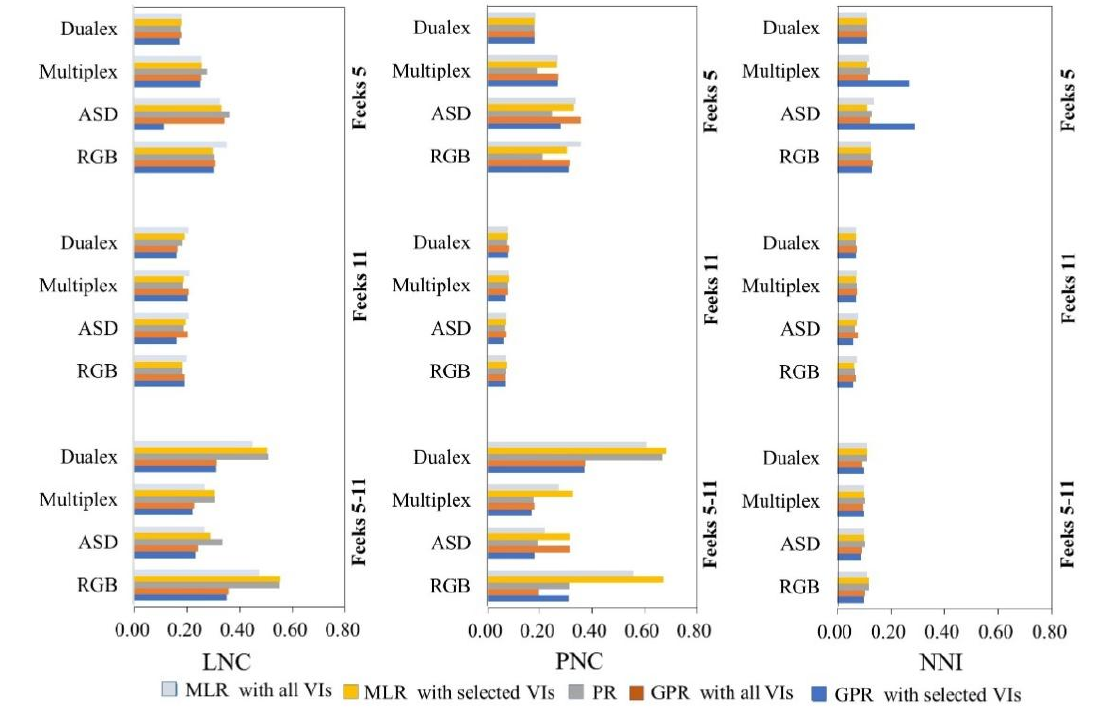
Figure 3. The MAE for LNC ( left ), PNC ( middle ), and NNI ( right ) estimation with different sensors through PR, MLR, and GPR methods.